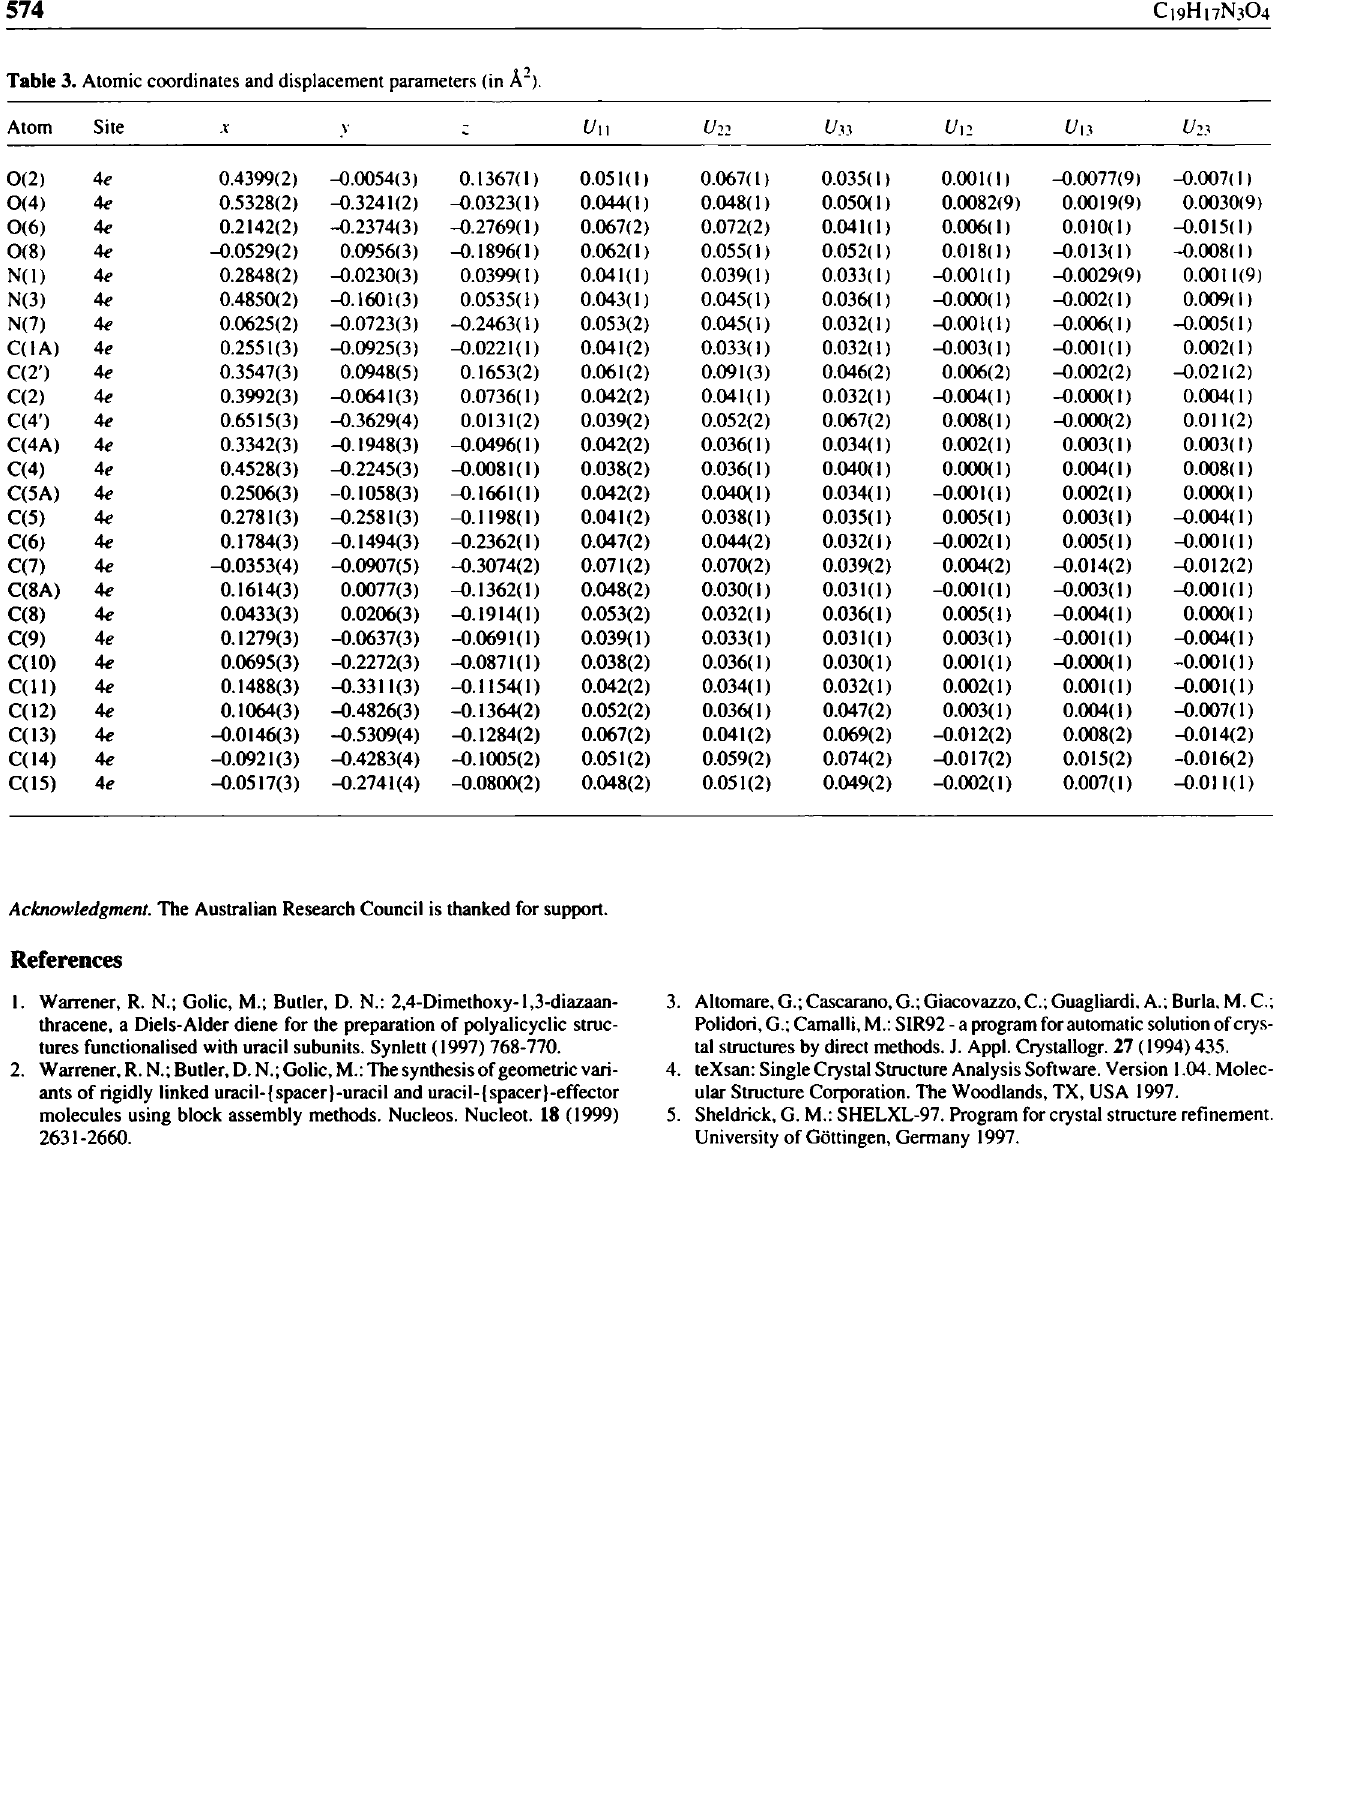
Table 3. Atomic coordinates and displacement parameters (in Ä 2